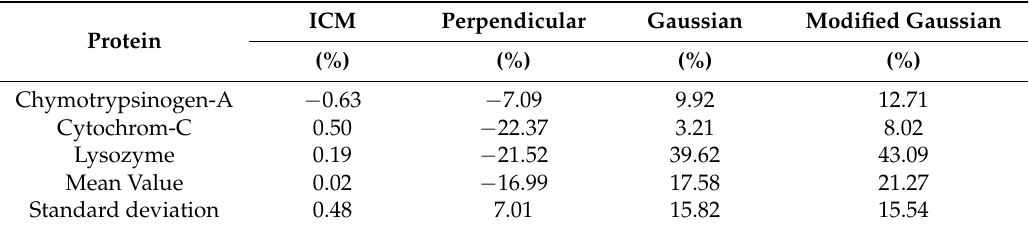
Table 2. Deviation from single component to mixture measurement.